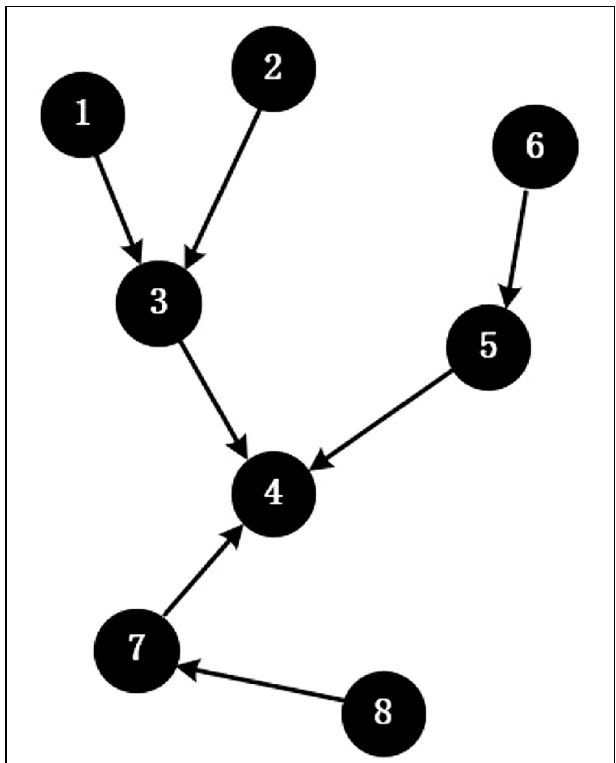
FIGURE 9 | Network routing for USVs.